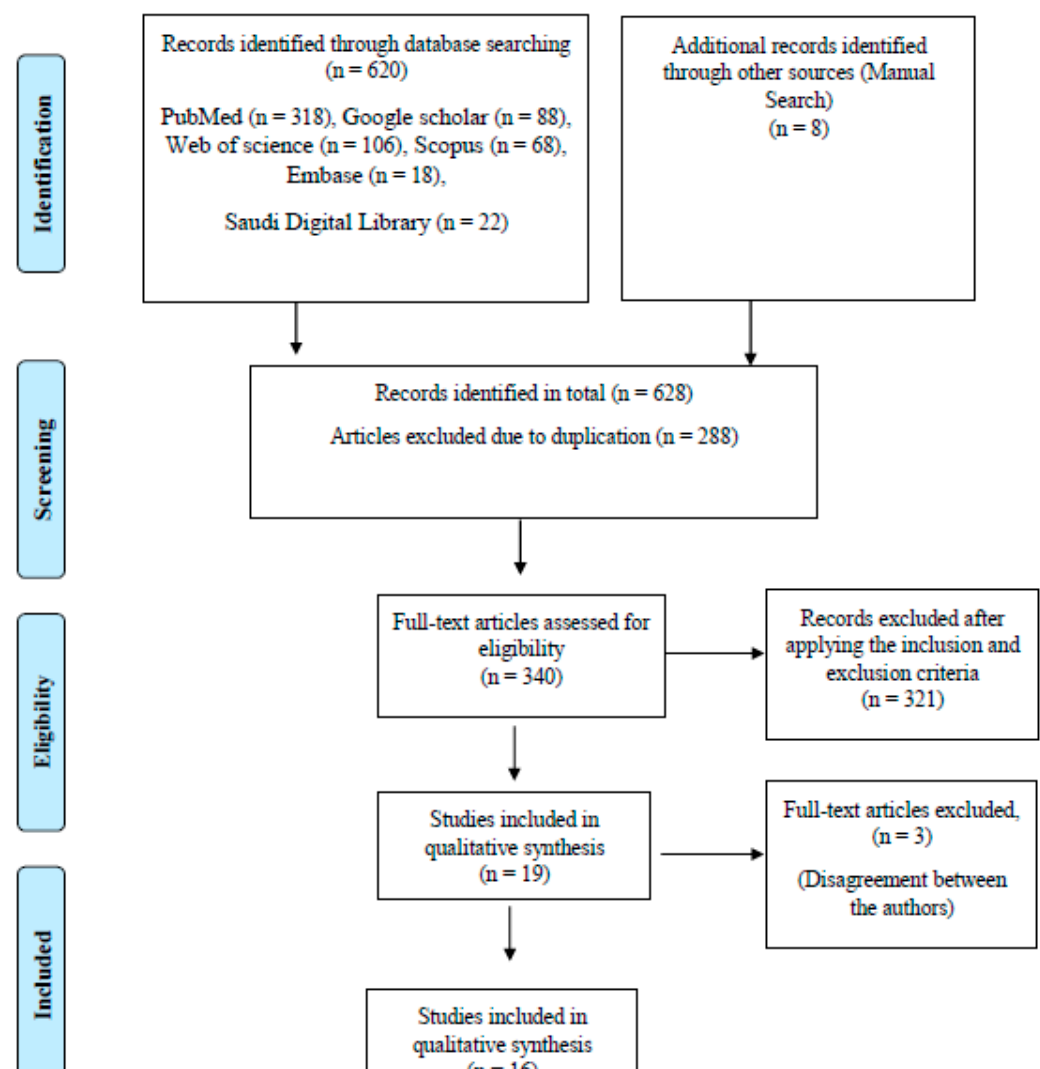
Figure 1. Flow chart for screening and selection of articles.